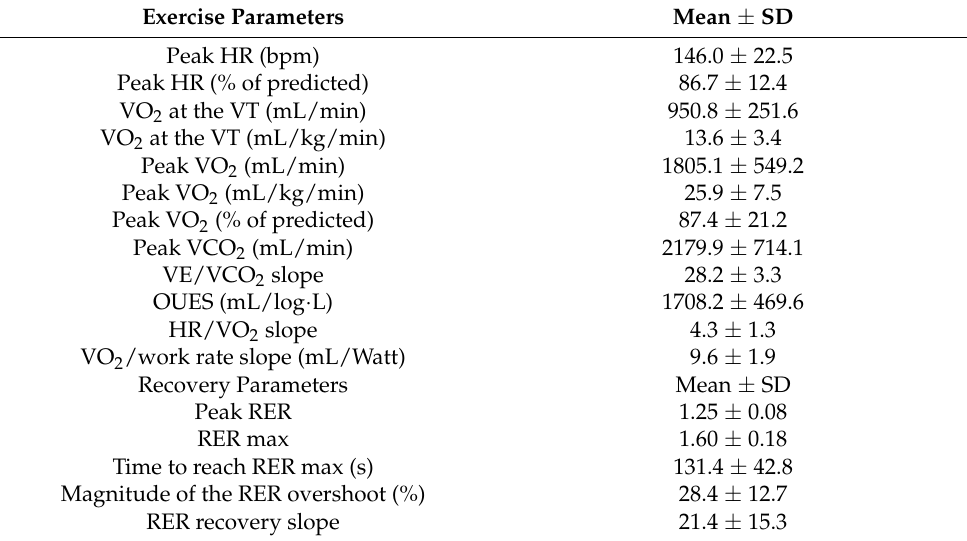
Table 2. Cardiopulmonary test parameters and recovery metrics of the whole population of kidney transplant